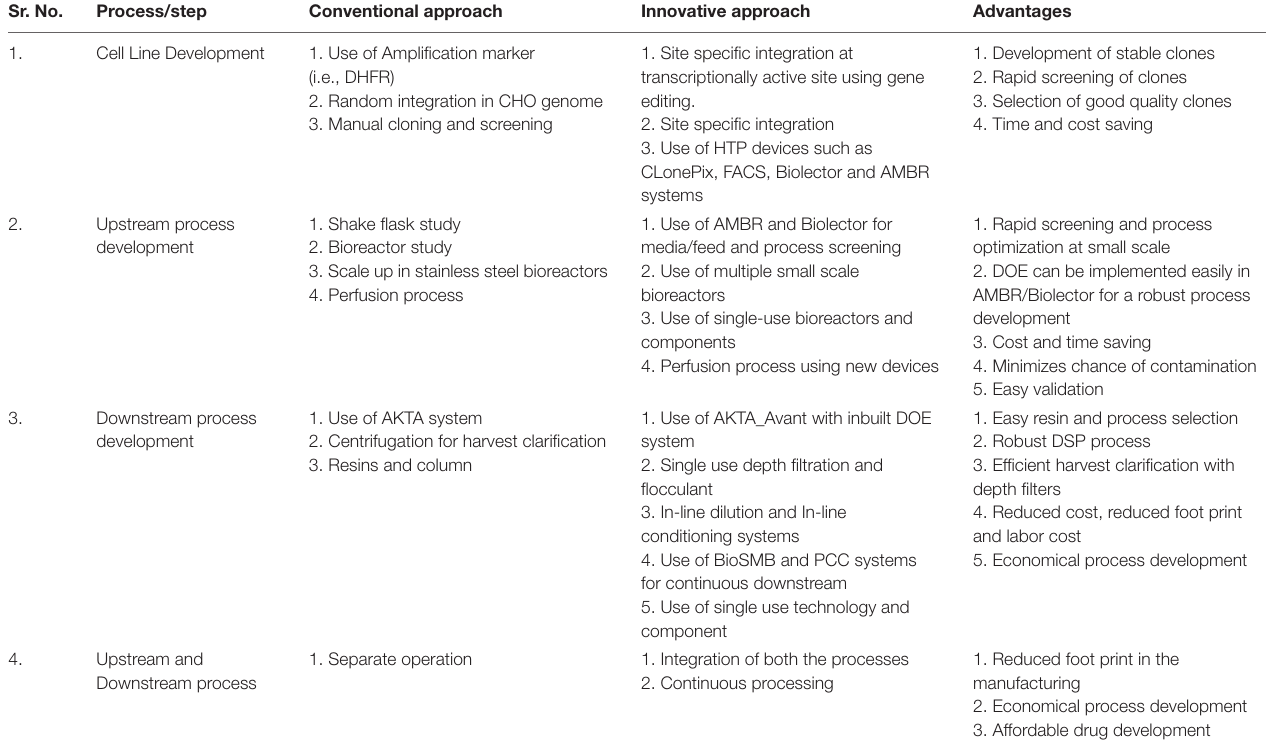
TABLE 3 | Summary of conventional and innovative approaches in manufacturing of recombinant products (del Val et al., 2010; Liu et al., 2010; Rita Costa et al., 2010; Shukla and Thommes, 2010; Bhambure et al., 2011; Angarita et al., 2015; Klutz et al., 2015; Zhao et al., 2015; Gupta and Shukla, 2016b). Sr. No.